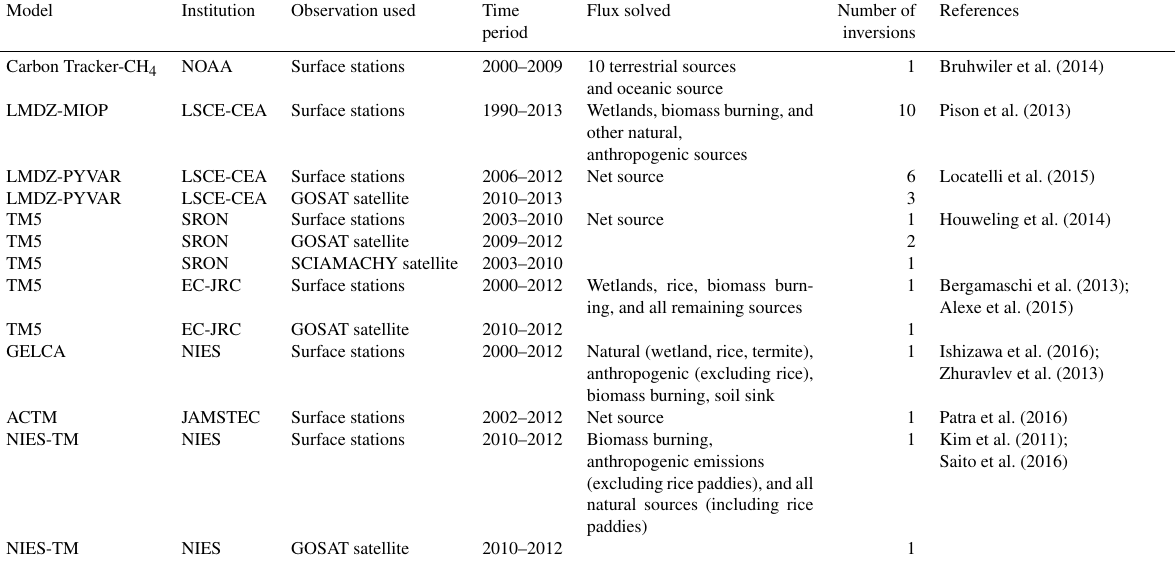
Table 1. List of the top-down estimates included in this paper.